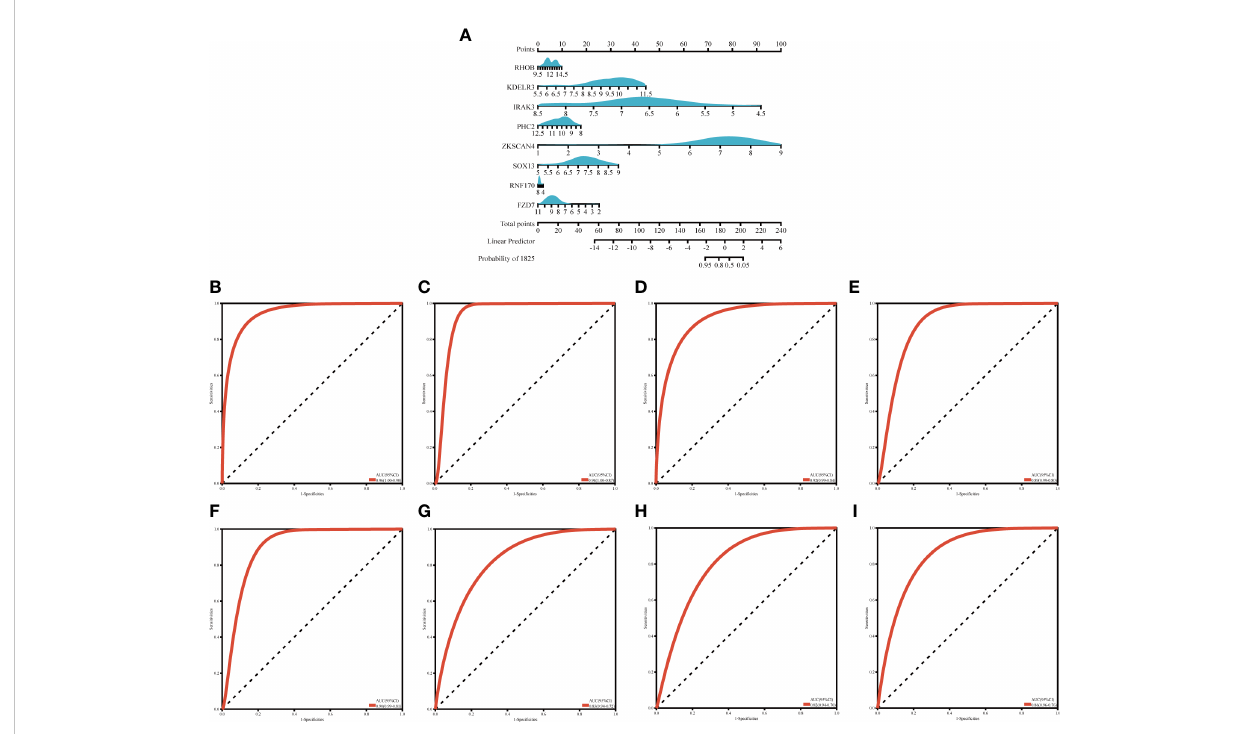
FIGURE 7 Nogrim comtraction and the diagnostic value evaluation (A) The visible nomogram for diagnosing OA with MetS (B – I) The ROC curve of each candidate gene (RHOR, KDELR3, TRAKA, PHC2, ZKSCANA, SOX13, RNF 170 and FZD7) and nomogram show the signi fi cant OA with MetS diagnostic value. OA. Osteoarthritis, MetS, Metabolic syndrome; AUC, area under the